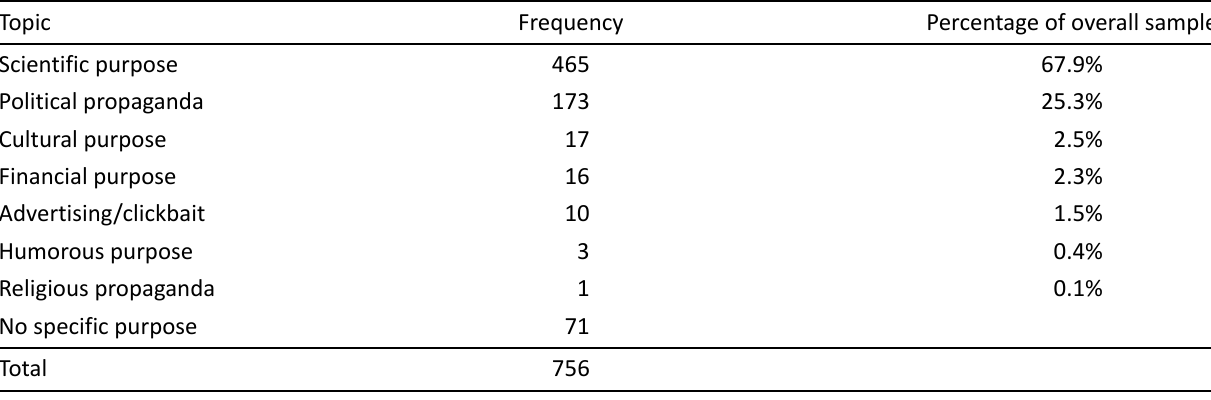
Table 7. The purpose of fake